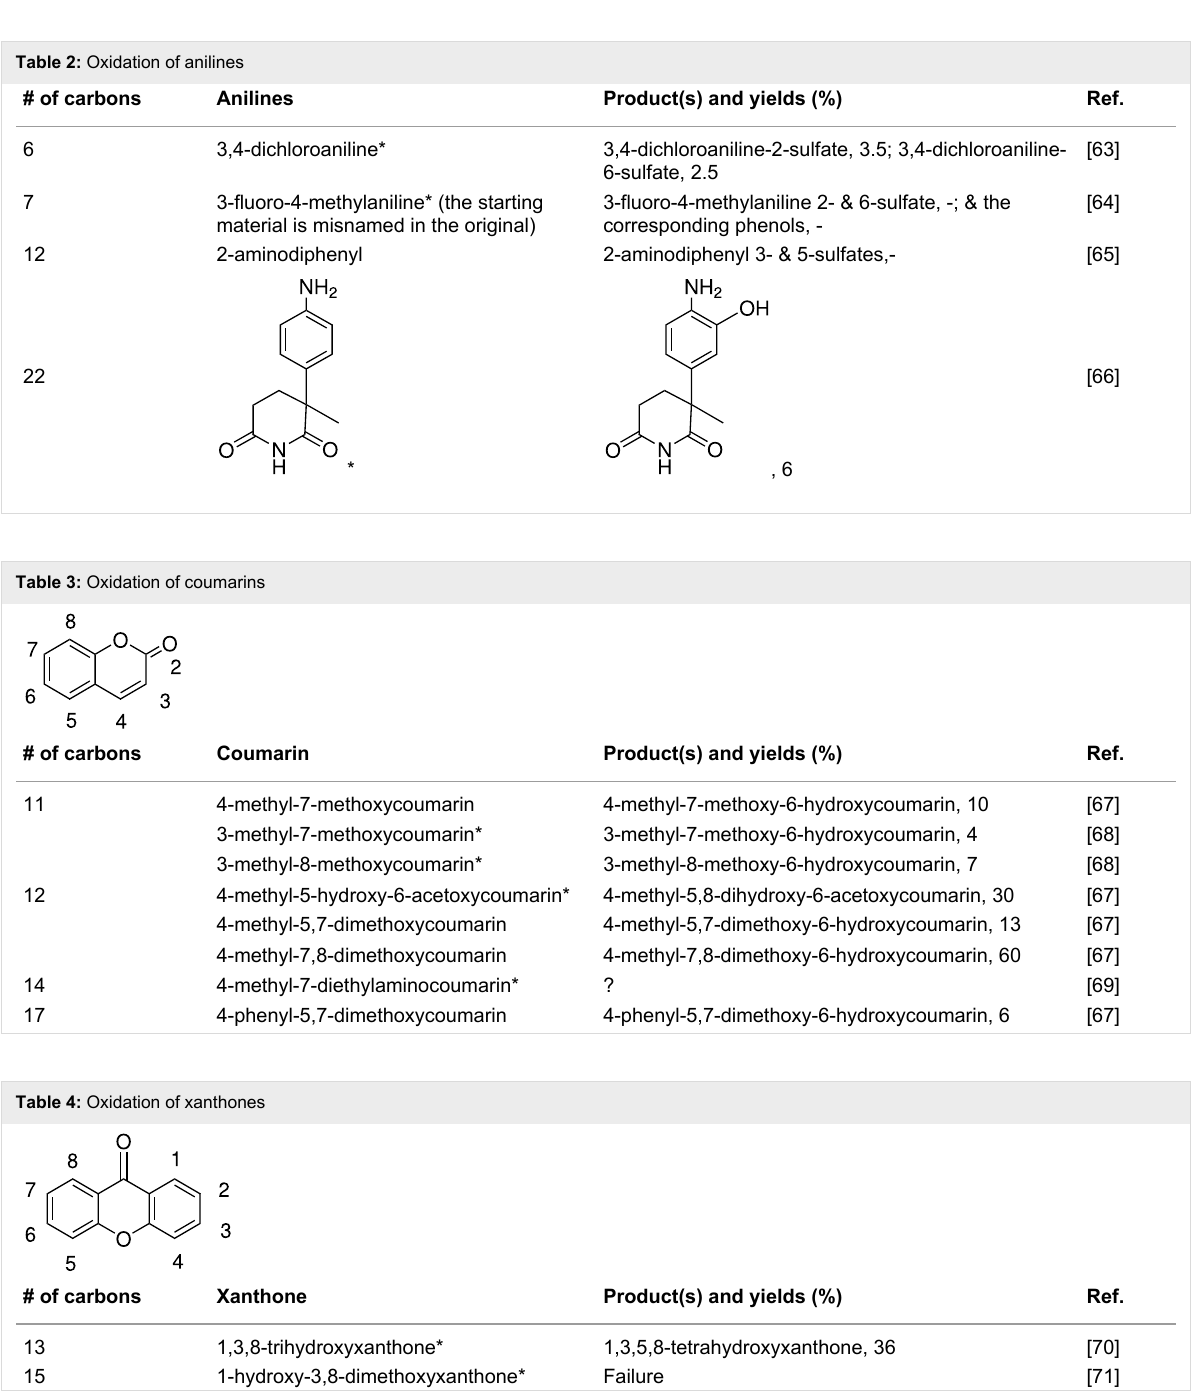
Table 2: Oxidation of anilines # of carbons Anilines